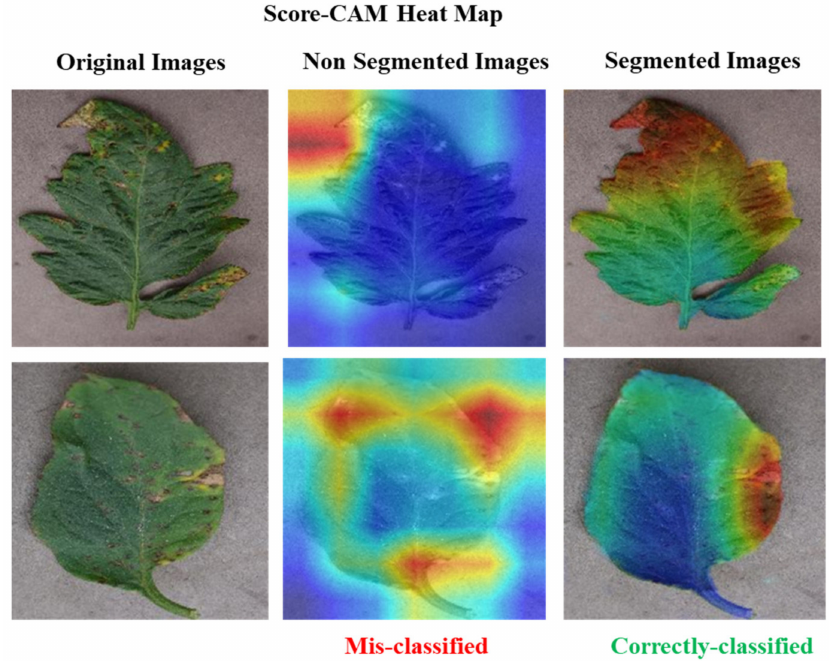
Figure 9. Score-CAM visualization to confirm how segmentation has helped in